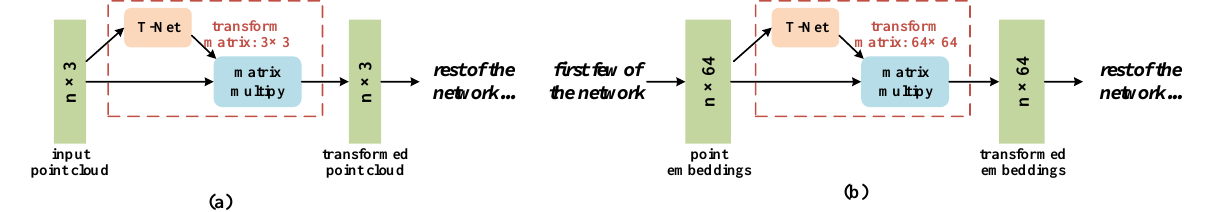
Figure 5. Point Cloud T-Net Network. ( a ) Input point cloud T-Net network; ( b ) Feature transformation T-Net network.